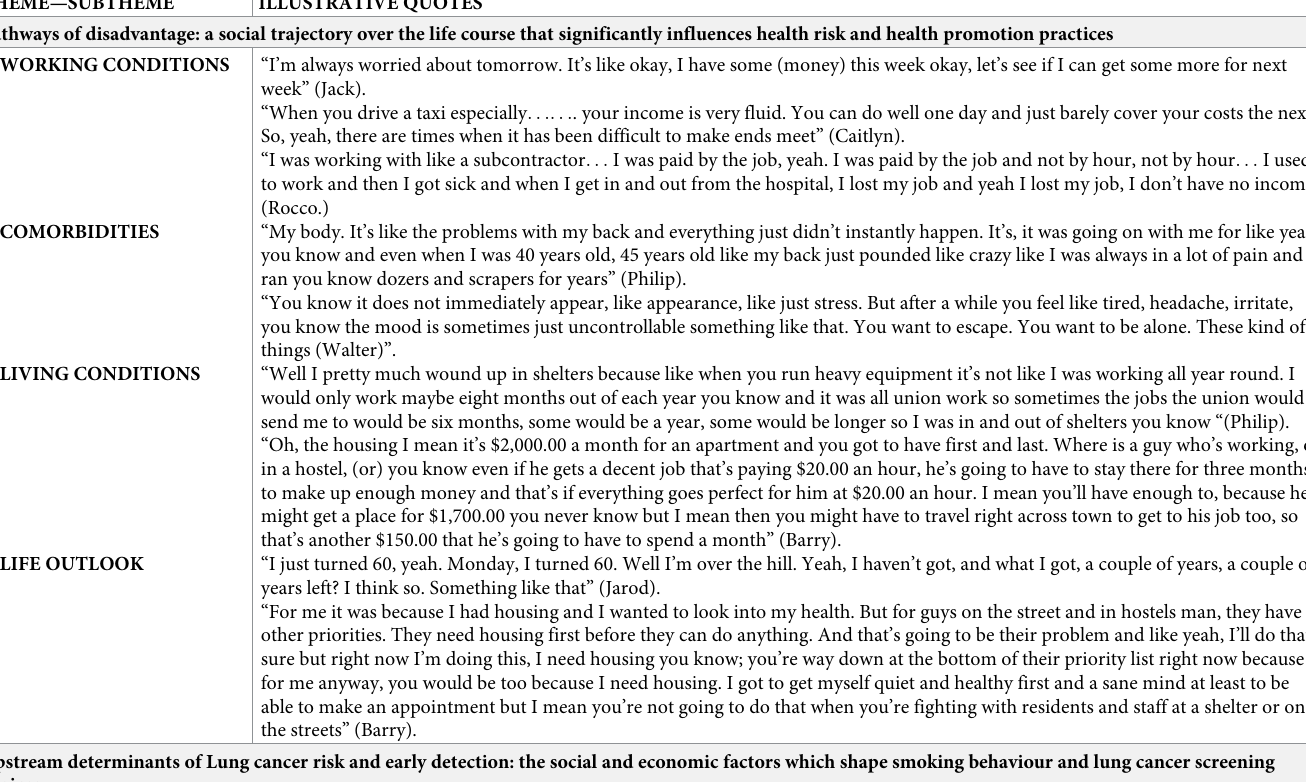
Table 2. Themes, subthemes, and illustrative quotes from interview transcripts.